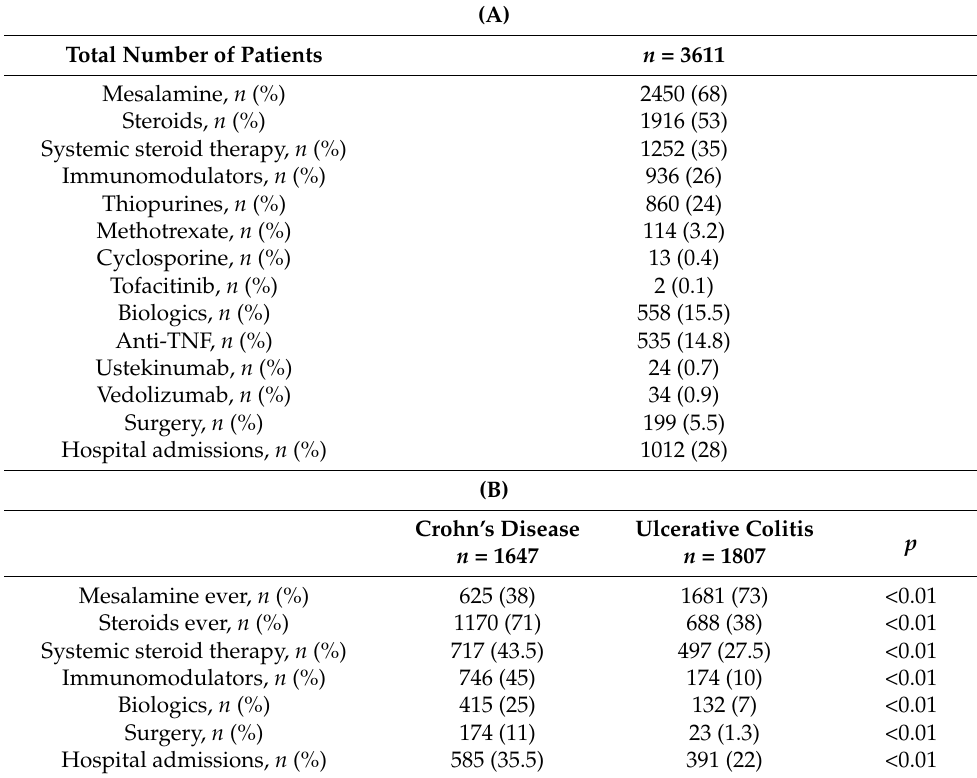
Table 3. Use of inflammatory bowel disease drugs, surgery and hospitalizations in the entire cohort ( A ) and based on inflammatory bowel disease type ( B ) in the first year after